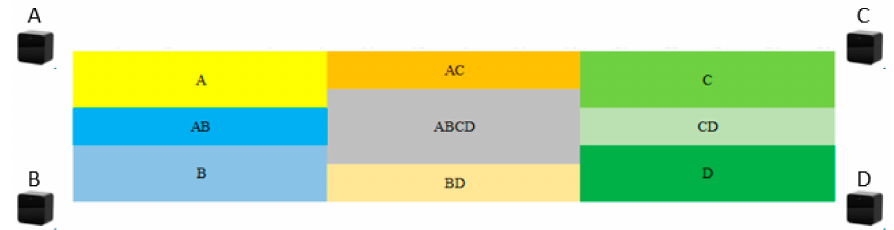
Figure 20. Distribution of Determination Blocks According to the Closest Base Station.